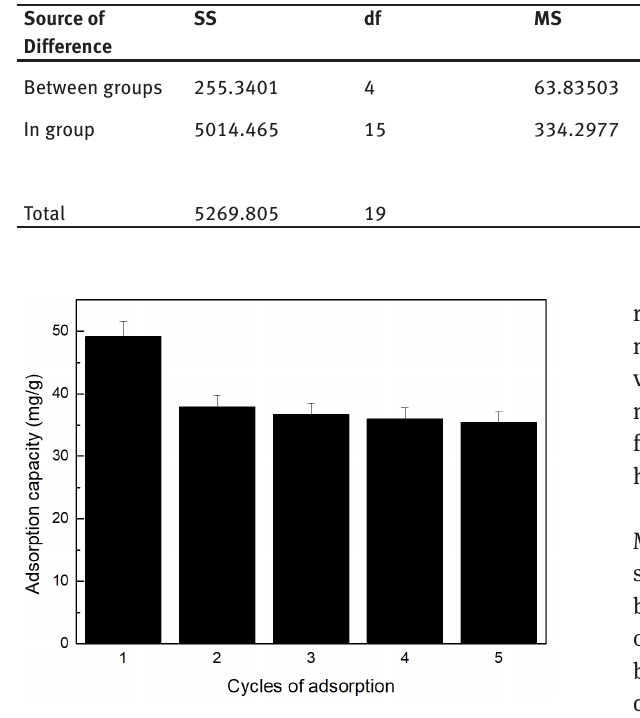
Figure 13: The recycling performance of adsorbent (Desorption and regeneration of the fermented Magnolia officinalis residues. 0.2 g of the adsorbent was used, and the adsorption occurred at 25°C with stirring at 150 r/min).